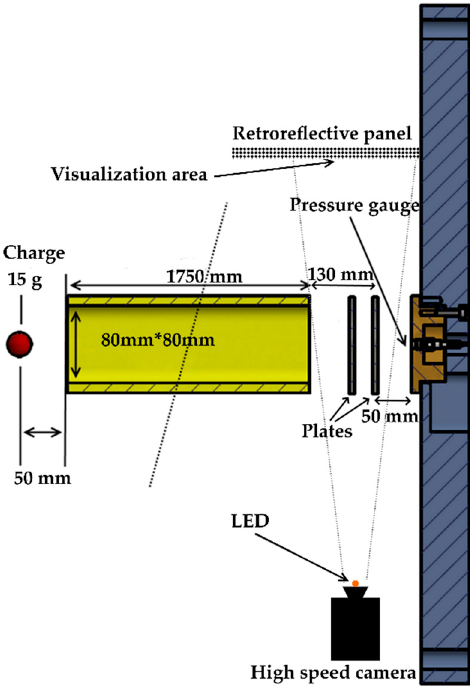
Figure 2. Schematic view of the explosive-driven shock tube and positioning of the pressure sensor and plates. The position of the high speed camera and of the retroreflective panel is also shown.